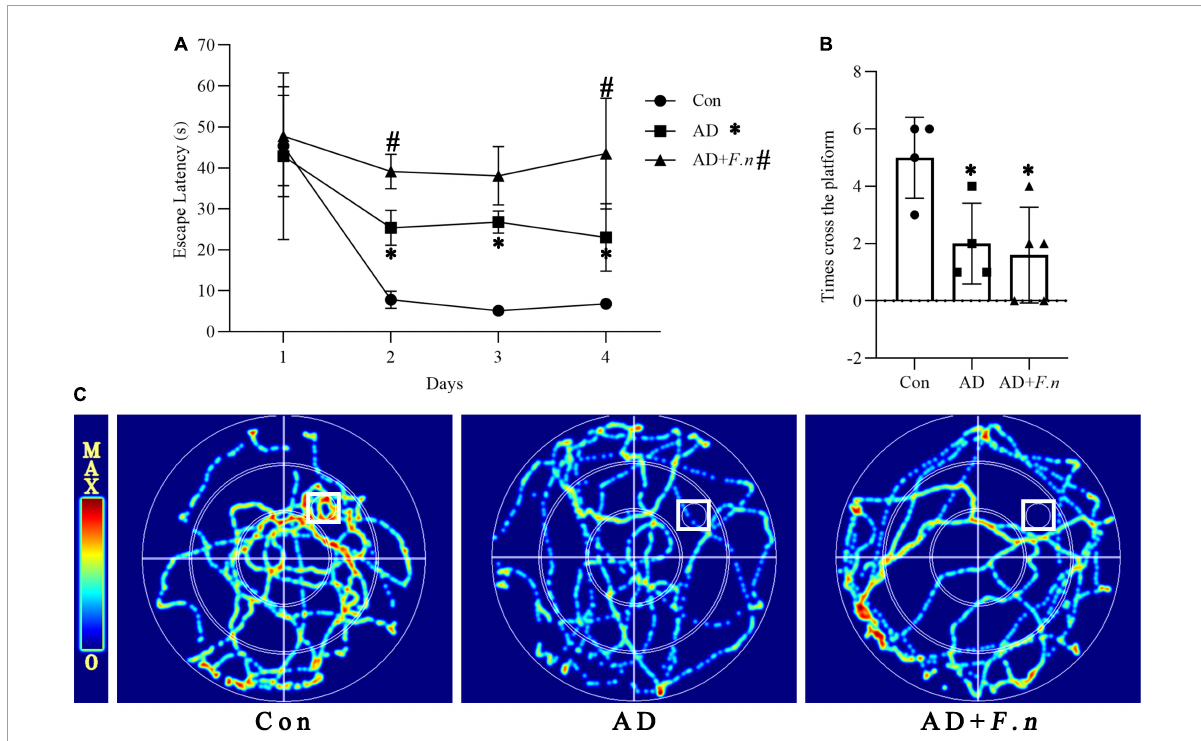
FIGURE2 Morris water maze test (MWMT) showed the cognitive ability of rats in each group. (A) Escape latency. (B) The number of times cross the platform. (C) Heat map of rat movement track. Data presented as mean ± SEM. n = 4–5 in each group, * P < 0.05 vs. Con group, # P < 0.05 vs. AD group, indicates statistically significant